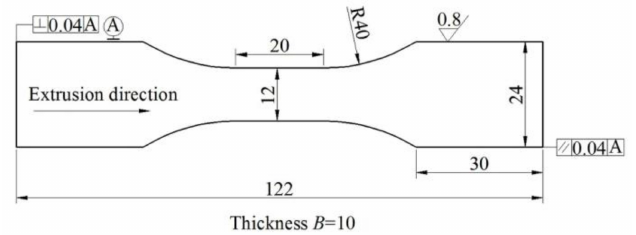
Figure 1. Fatigue strength specimen geometry (mm).